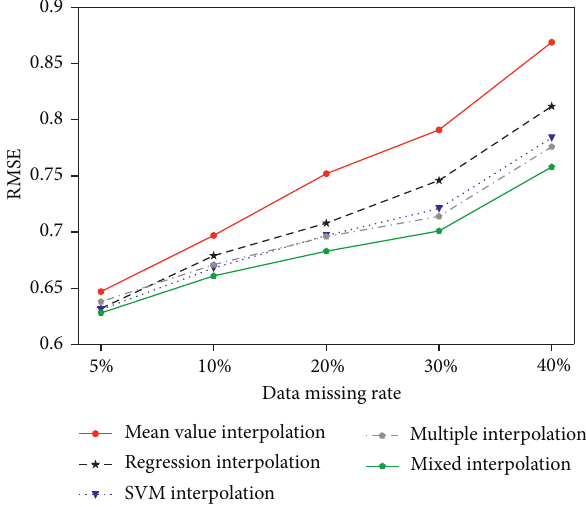
Figure 9: RMSE values of the five interpolation methods under different data miss rates.